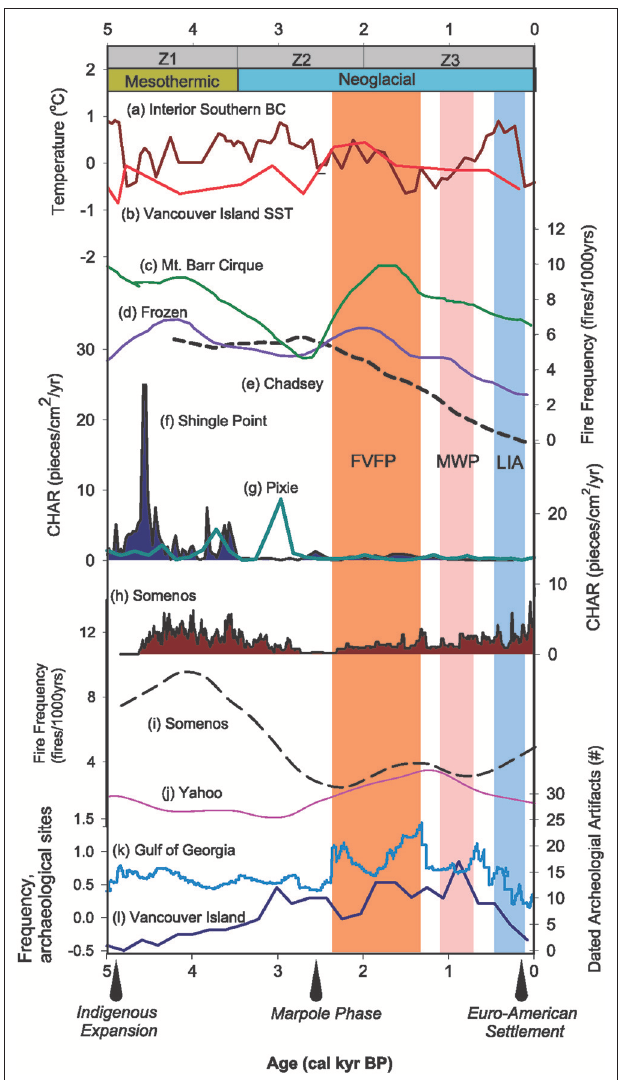
FIGURE 4 | Regional synthesis of charcoal-inferred fire activity and major anthropogenic and climatic changes in southwestern BC and western Washington over the last ∼ 5,000 years. Gray bars indicate Zones 1 (ca. 5,000–3,500 cal yr BP), 2 (3,500–2,000 cal yr BP), and 3 (2,000 cal yr BP to present). Climate periods depicted are the warm, moist Mesothermic (yellow bars) (Hebda, 1995) and cool, moist Neoglacial (blue bars) (Walker and Pellatt, 2003), and the Fraser Valley Fire Period [FVFP, medium red, Hallett et al. (2003)], the Medieval Warm Period [MWP, light red, Mann et al. (2009)], and the Little Ice Age [LIA, light blue, Grove (2001)] that fall within the Neoglacial. Temperature anomaly records are from (a) interior southern BC [red line, Gavin et al. (2011)] derived from chironomid reconstructions from four lakes in southern-to-southeastern BC (Palmer et al., 2002; Rosenberg et al., 2004; Chase et al., 2008) and (b) alkenone-derived sea-surface temperatures from deep-sea core JT96-09PC off the coast of Vancouver Island (Kienast and McKay, 2001). The mean temperature estimated over 0 to 10,000 cal yr BP was subtracted from all values. Fraser Valley fire frequency records include: (c) Mt. Barr Cirque Lake (Hallett et al., 2003), (d) Frozen Lake (Hallett et al., 2003), and (e) Chadsey Lake (this study). CHAR records are taken from: (f) Valdes Island On-site Bog from Shingle Point (Derr, 2014), (g) Pixie Lake (raw, unsmoothed data) (Brown and Hebda, 2002b), and (h) Somenos Lake (this